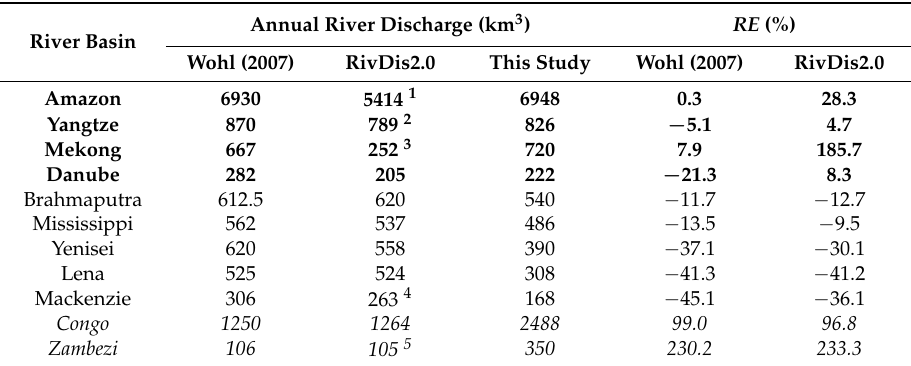
Table 1. Comparison of the annual river discharge values in this study and the existing global river discharge databases for the world’s major river